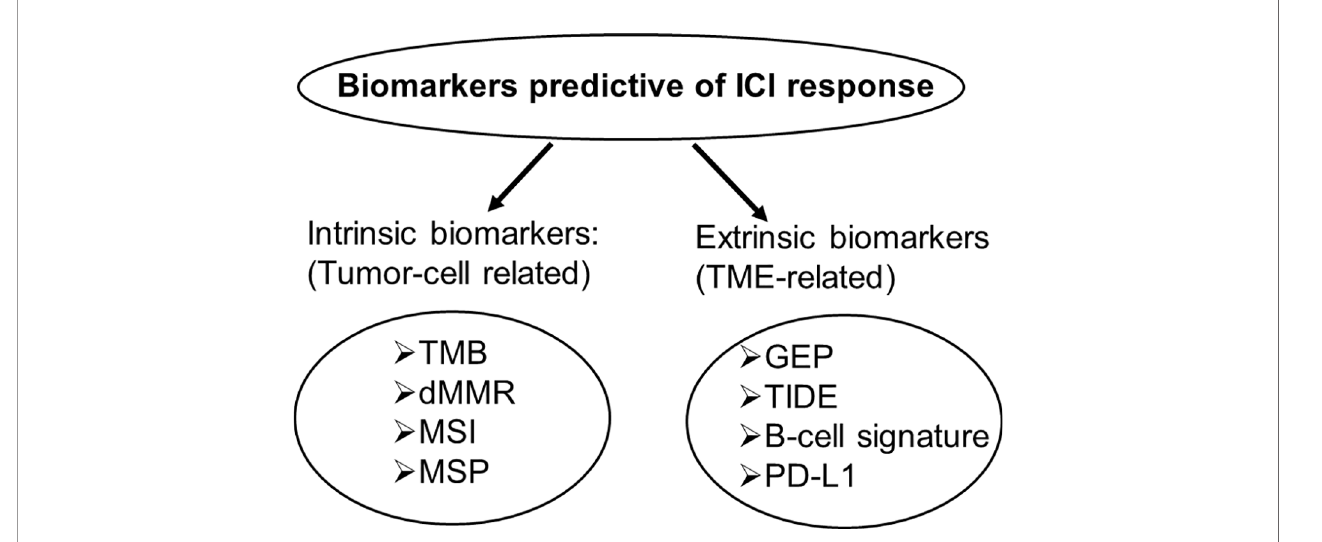
FIGURE 1 | Intrinsic and extrinsic biomarkers predictive of ICI response. Intrinsic biomarkers are tumor cell-related, extrinsic biomarkers are tumor